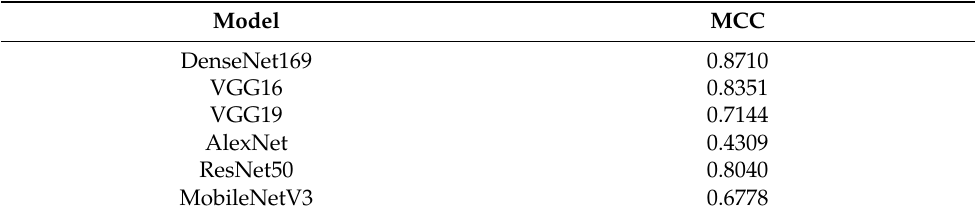
Table 6. MCC performance results of the deployed pretrained DL models with U-net segmentation.